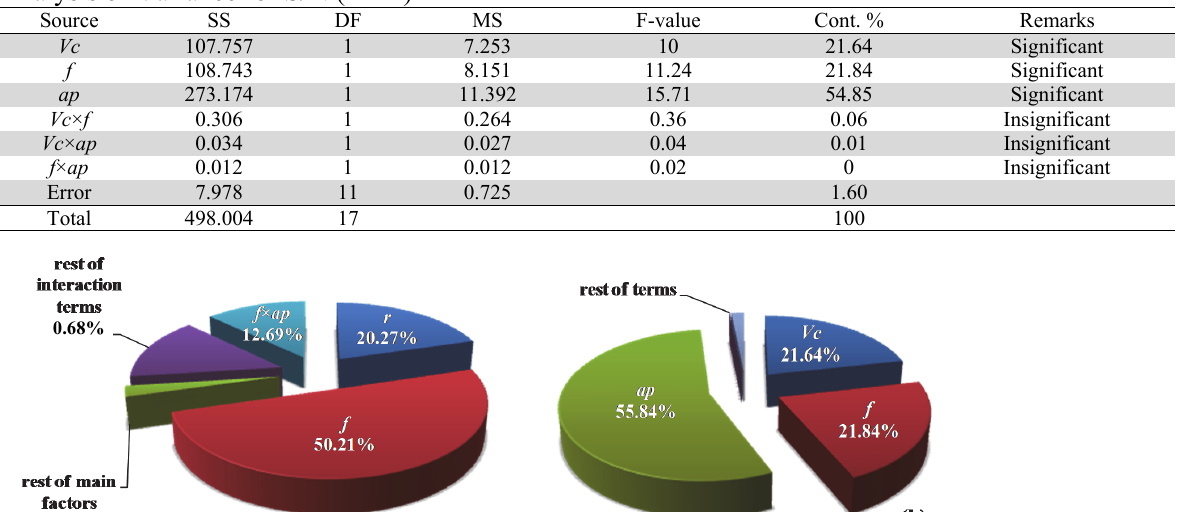
Analysis of Variance for S/N ( MRR )